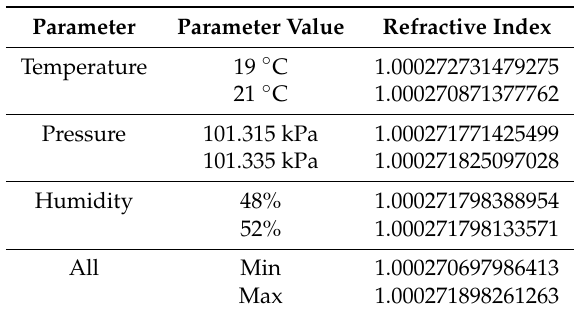
Table 2. Atmospheric parameters and their corresponding refractive